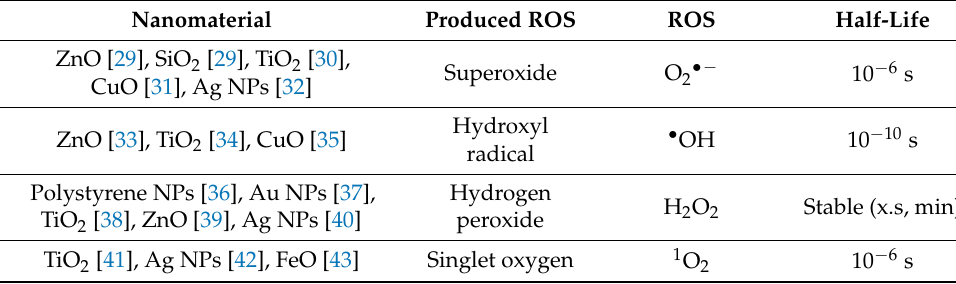
Table 1. Overview of nanomaterials capable of ROS production